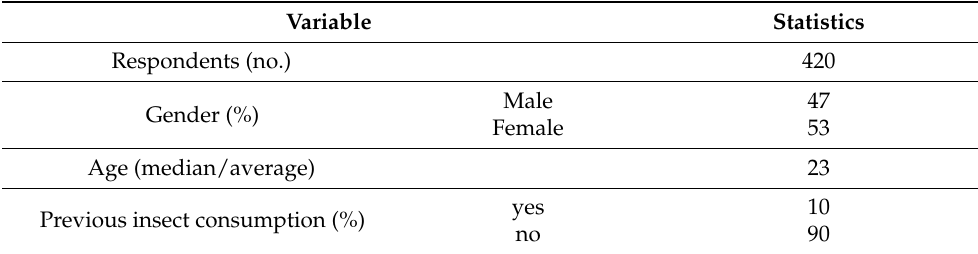
Table 1. Characteristics of the